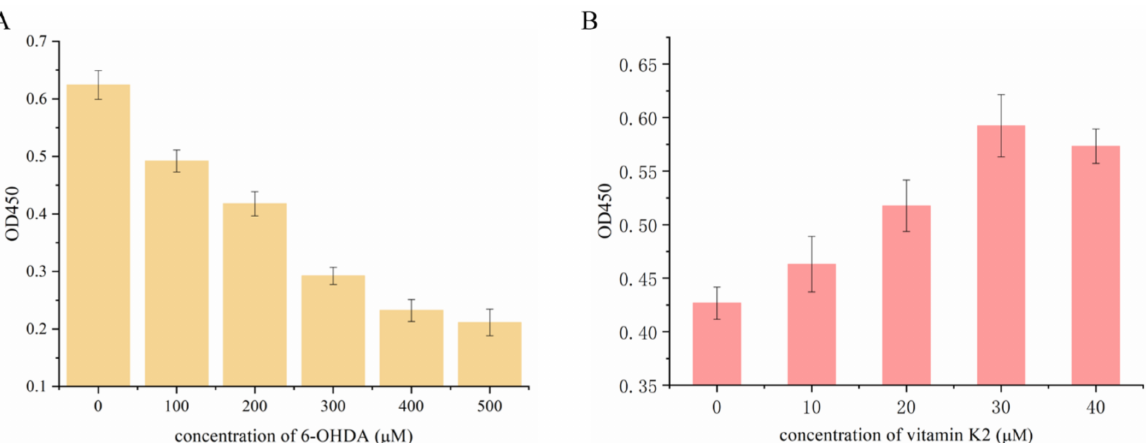
Figure 1. Measurement of SH-SY5Y cell viability after ( A ) treatment with different concentrations of 6-OHDA (0–500 µ M) for 2 h and ( B ) 300 µ M 6-OHDA treatment for 2 h and post-treatment with vitamin K2 for 6 h. The data are presented as mean ± SD ( n =